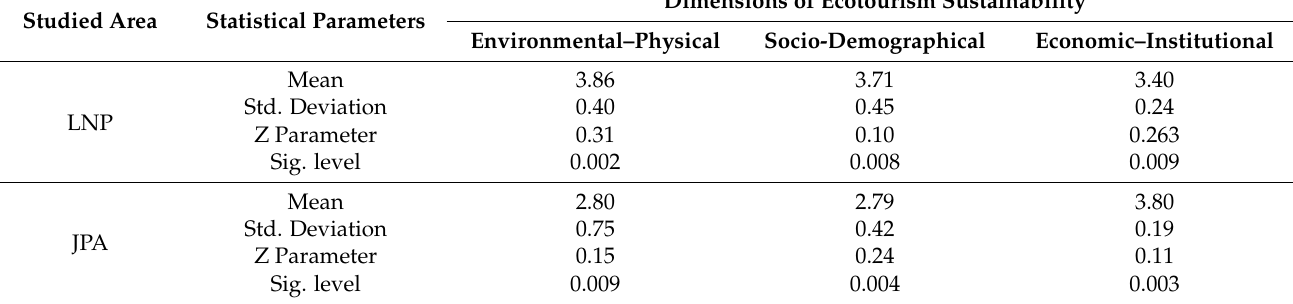
Table 3. Results of the Kolmogorov–Smirnov test.